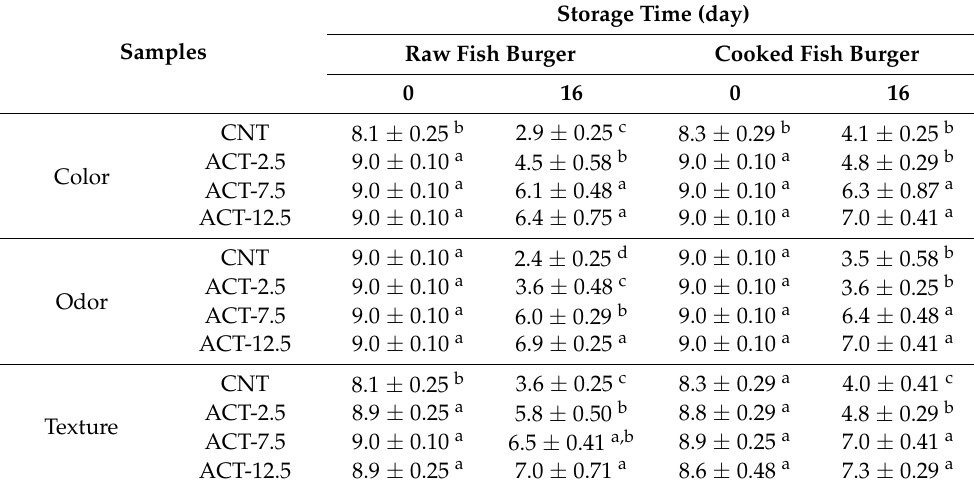
a–d Data indicate means ± SD. For each sensory attribute, the values marked with different superscript letters in the column are significantly different ( p < 0.05). CNT: fish burger without prickly pear powder; ACT-2.5: fish burger enriched with 2.5 g of prickly pear powder; ACT-7.5: fish burger enriched with 7.5 g of prickly pear powder; ACT-12.5: fish burgers enriched with 12.5 g of prickly pear powder. Table 5. The effect of prickly pear enrichment on the color parameters of fish burgers.